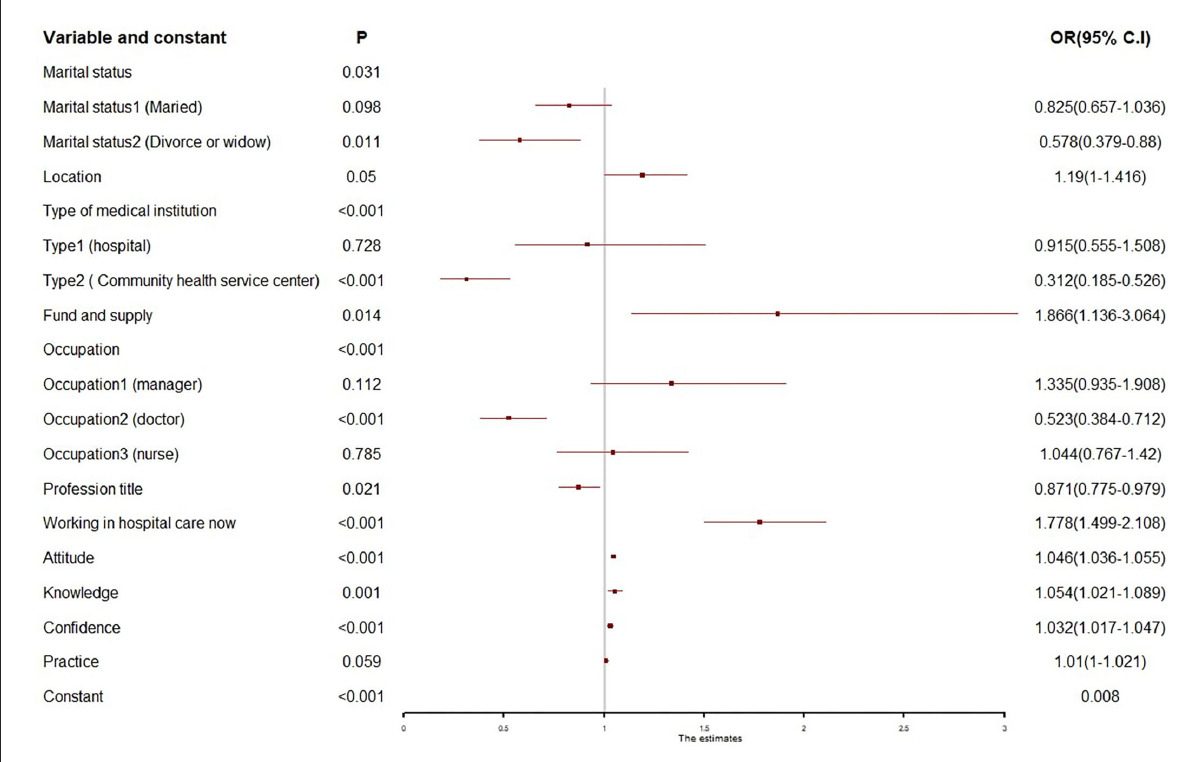
FIGURE2 Forest plot of binary logistic regression. Only the variables with statistical significance were displayed in the plot.